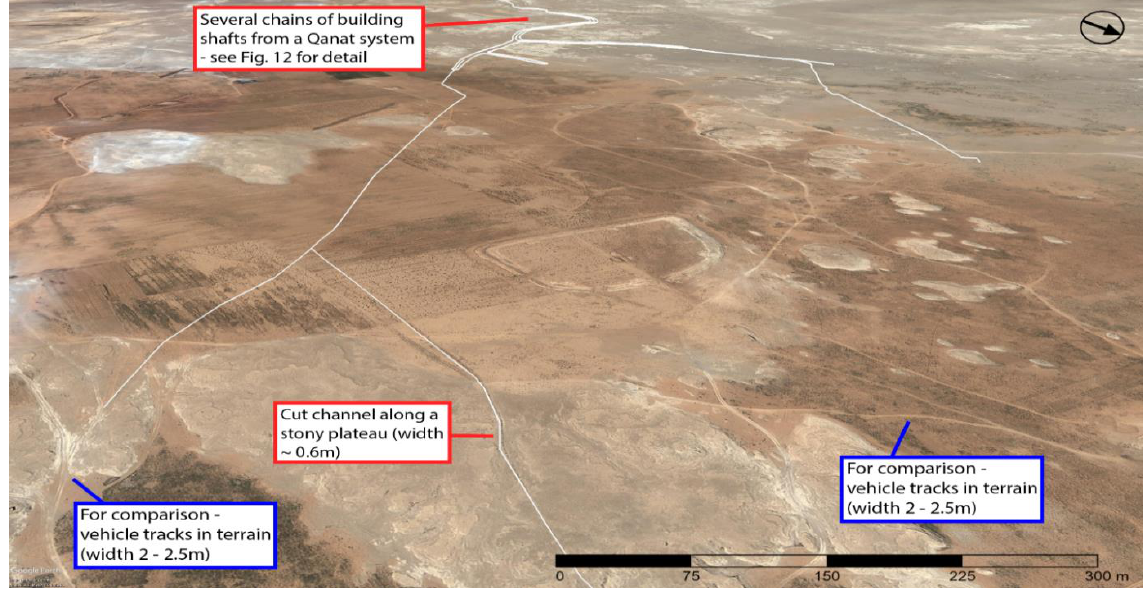
Figure 13: Stone plateau with cut-in channels west of Ar-Rafi'ah. Oblique view from the East. (Google / Maxar Technologies 2021)